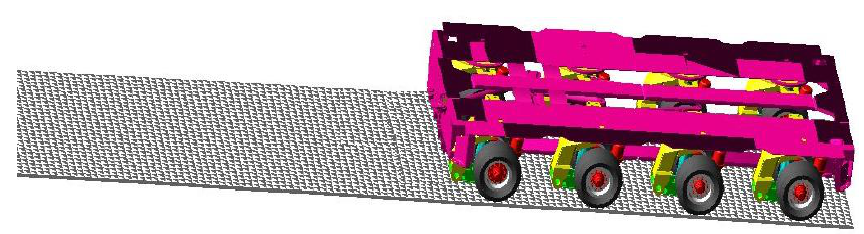
Figure 9. The model of the whole vehicle.